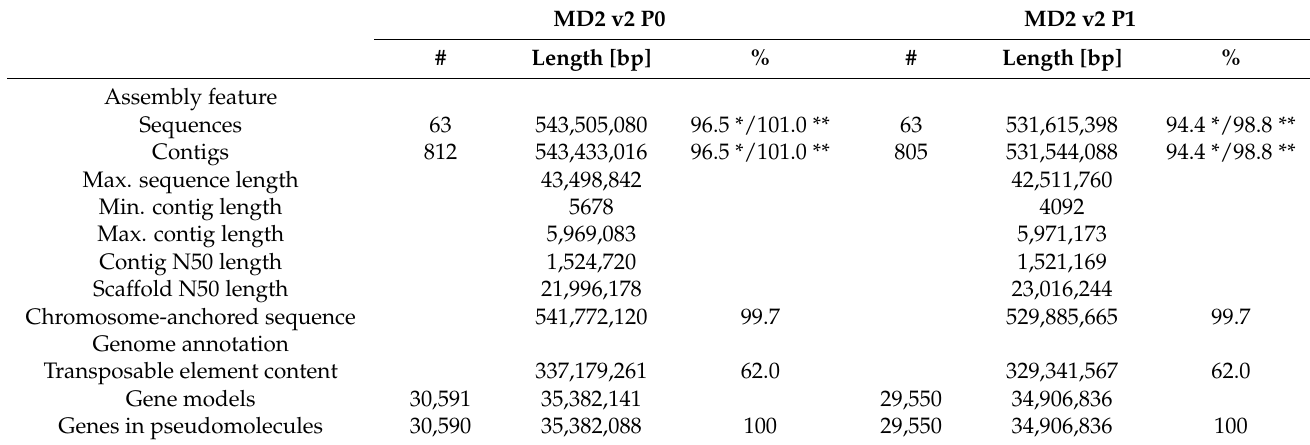
Table 1. Statistics of the MD2 v2 pineapple genome assembly and gene